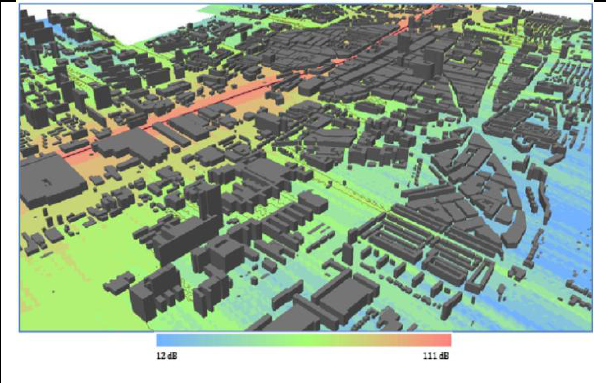
Figure 3. Noise modelling in 3D (caused by a railway in downtown Delft) would benefit from having more detail available close to the source of the noise, while further away less detail is